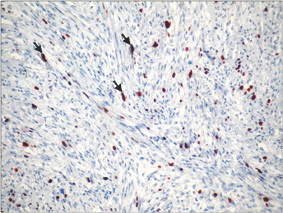
Microscopic appearances of immunohistochemical analyses. Approximately 15% of tumor cells show nuclear positivity for Ki-67 (MIB-1) (arrows) (Ki-67 immunostain, ×200).